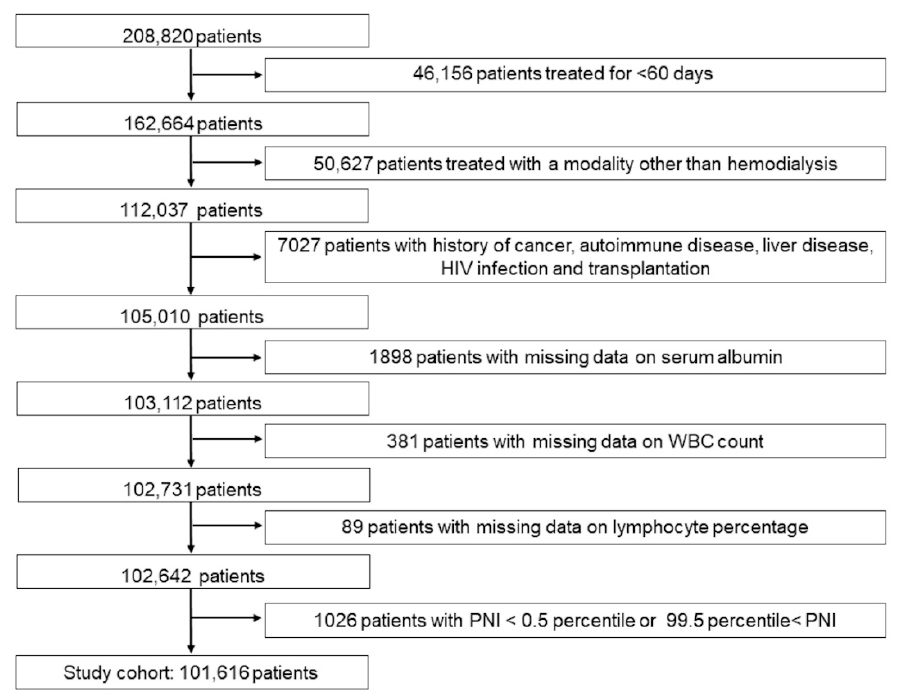
Figure 1. Flowchart of patient selection in the study cohort. Abbreviations: PNI, prognostic nutri- tional index; HIV, human immunodeficiency virus; WBC, white blood cell. The final cohort’s demographics included a mean age of 63 ± 15 years, 56% male, 46% Caucasian, 15% Hispanic, and a mean PNI value of 42.9 ± 5.4. Baseline characteristics